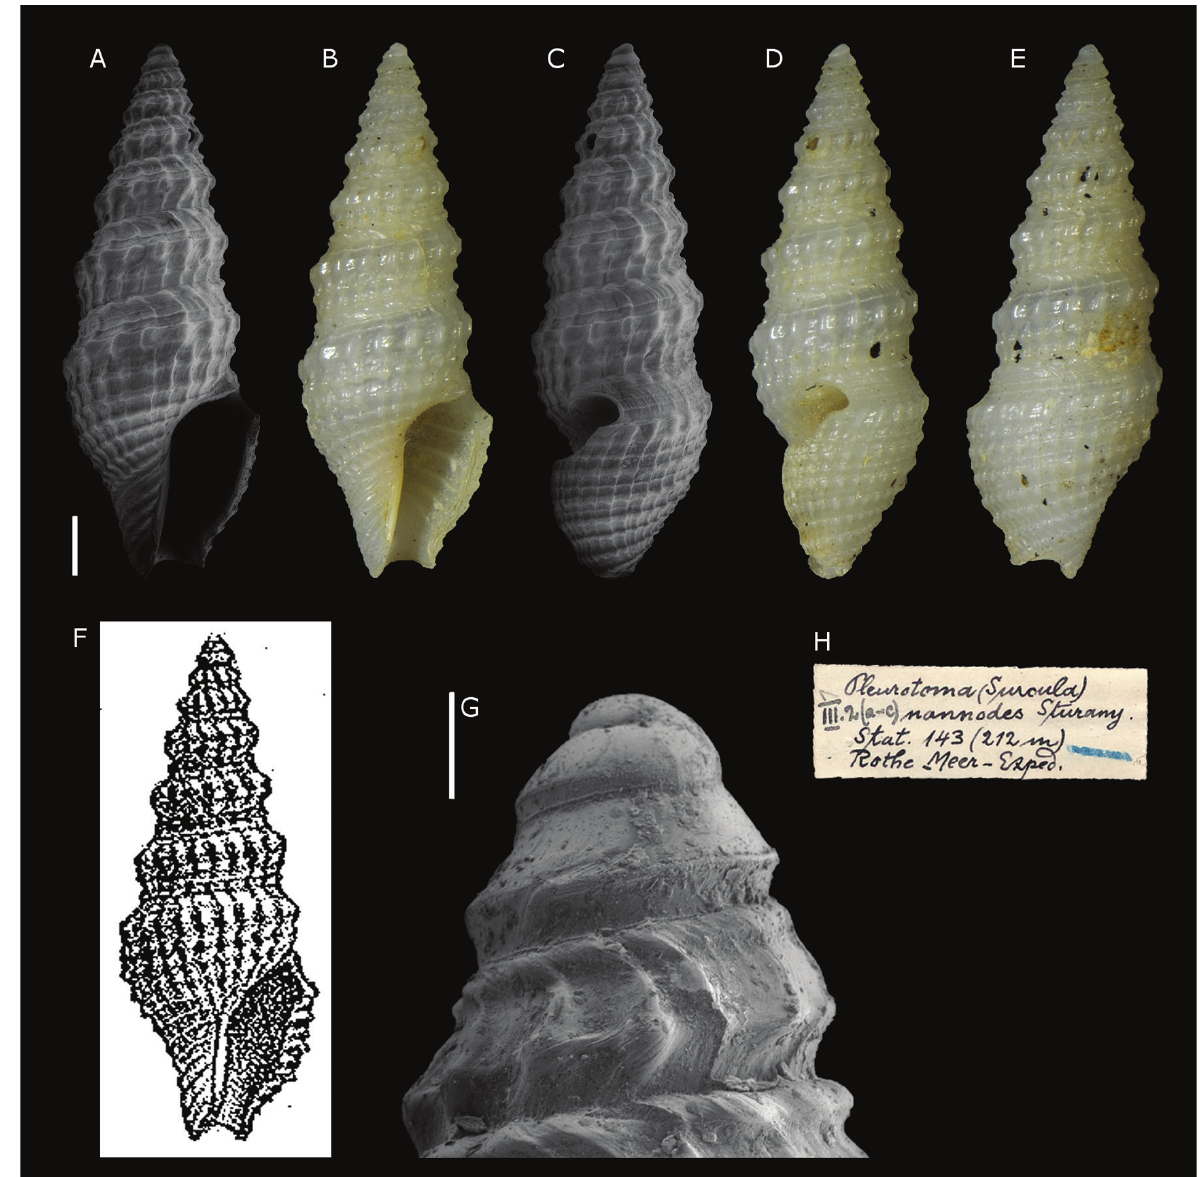
Figure 24. Pleurotoma nannodes Sturany, 1900, Station 143 (Harmil Island, Dahlak Archipelago, Eritrea, Red Sea). A–E, G . Figured syntype, NHMW 84254: front ( A–B ), right side ( C–D ), back ( E ), protoconch ( G ). F . Original figure by Sturany (1903). H . Original label. Scale bars: A–E : 1 mm, G : 0.2